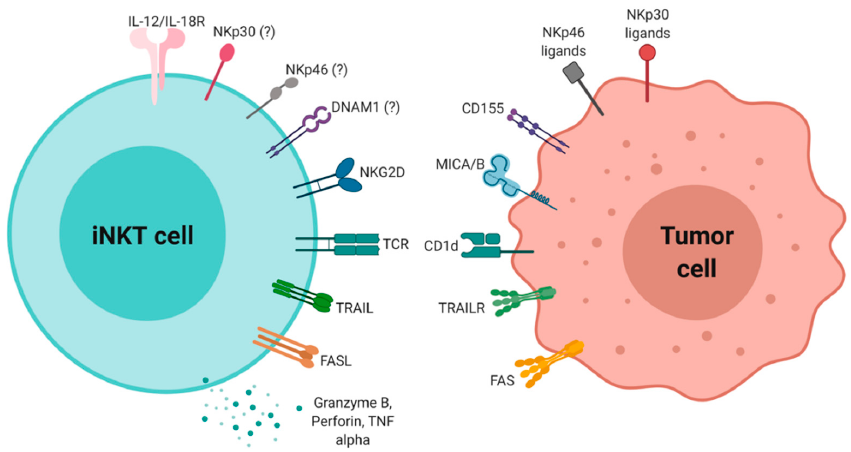
Figure 3. Activation signals and mechanisms of NKT cell cytotoxicity against tumors.